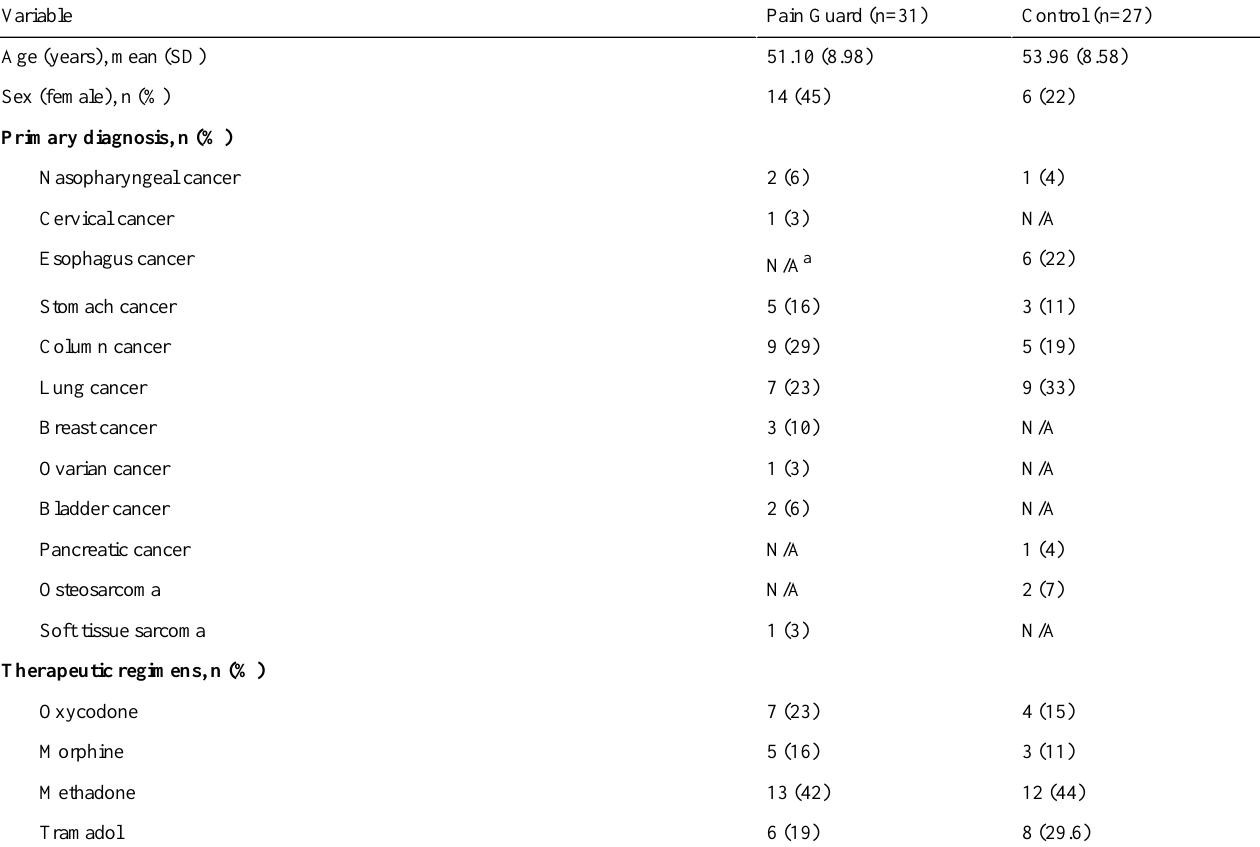
Table 1. Characteristics of participants at baseline (N=58).